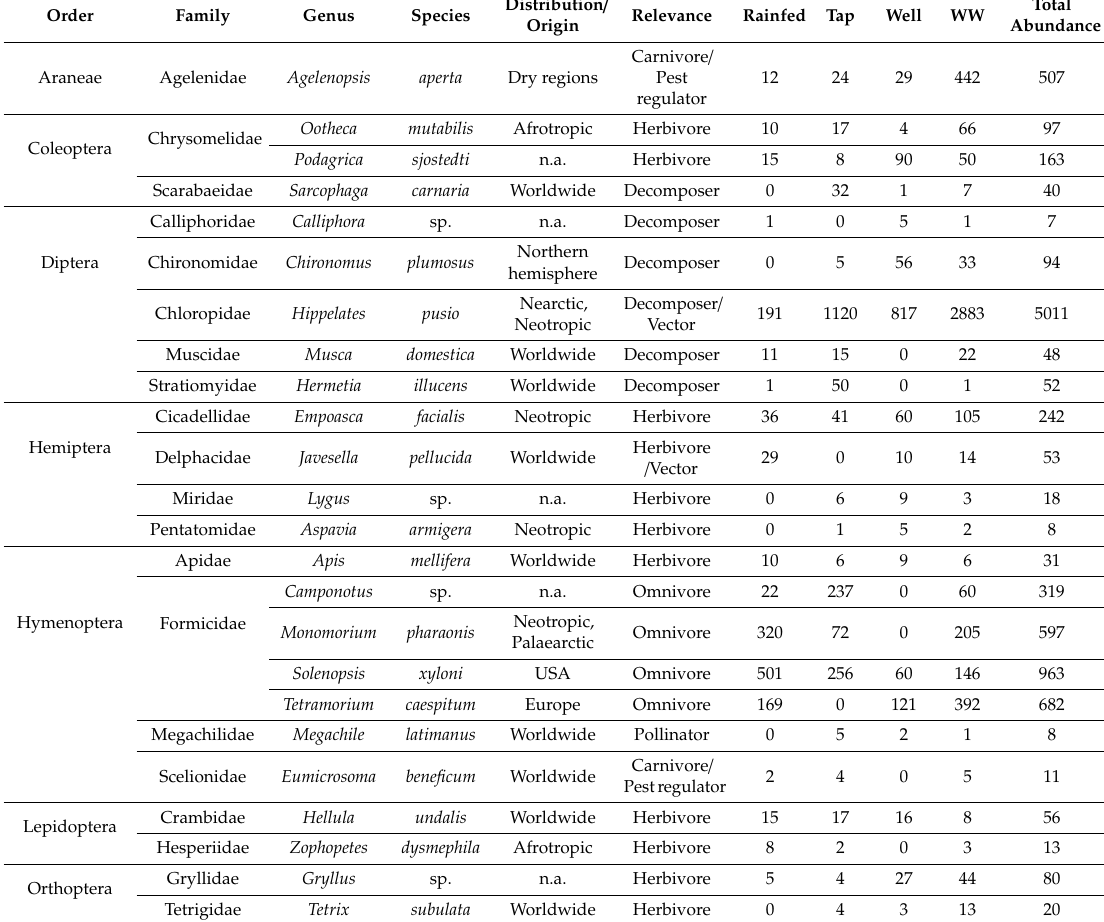
Table 5. Ecological relevance and abundance of the 24 most abundant and equally distributed arthropod species found on vegetable fields under di ff erent irrigation sources, namely, rainfed (RF), tap water (Tap), well water (Well), and wastewater (WW) in Tamale, Ghana, in